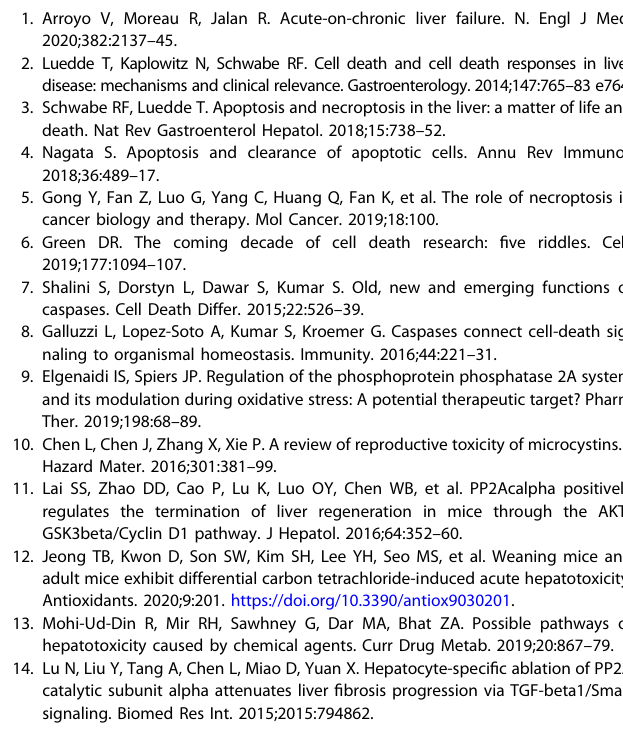
Fig. 7 PP2Ac α was involved in apoptosis and necroptosis via ASK/JNK signaling. Representative images ( A ) (scale bar, 100 μ m) and quanti fi cation of ROS staining ( B ) ( n = 5) of primary hepatocytes isolated from Cre − and PP2Ac α CKO mice with DMSO or CCl 4 treatment. Representative images ( C ) (scale bar, 50 μ m) and quanti fi cation of ROS staining ( D ) ( n = 5) of primary hepatocytes stimulated with 5 nM NAC +